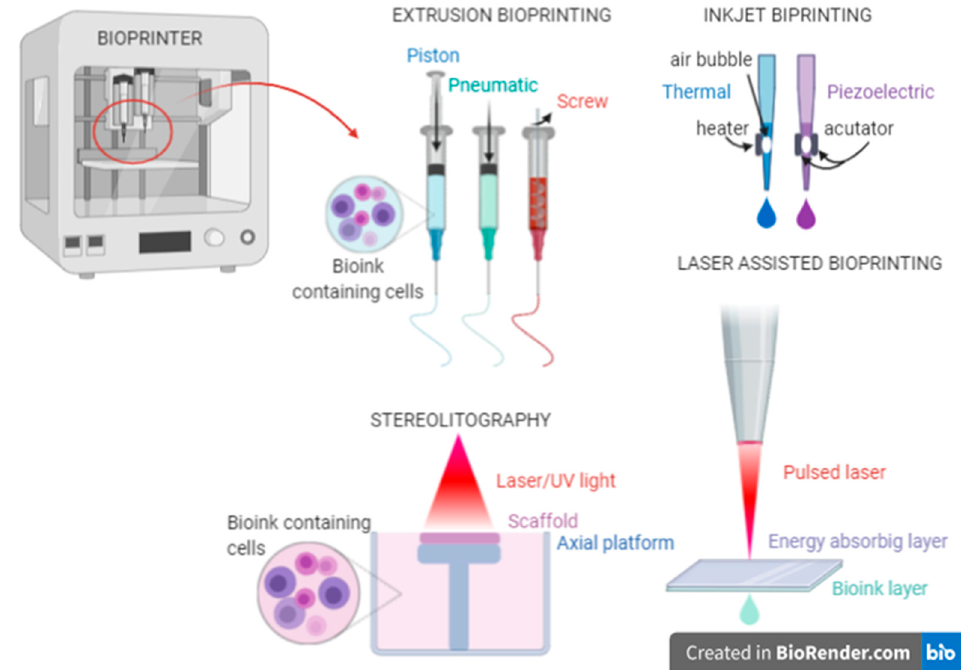
Figure 5. Commonly used 3D bioprinting methods.